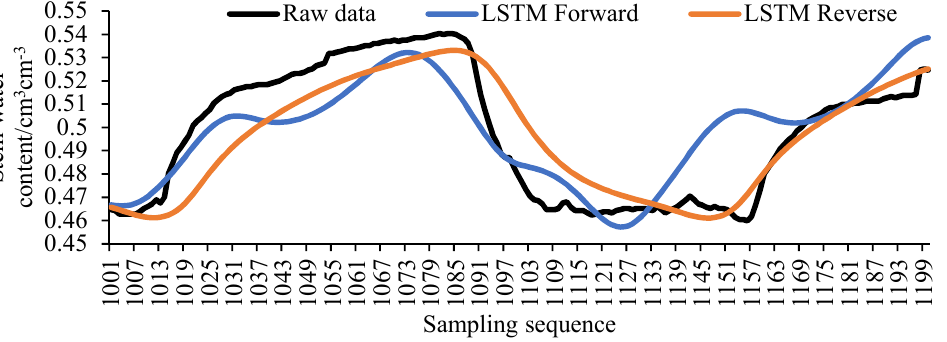
Figure 8. The LSTM unidirectional model.